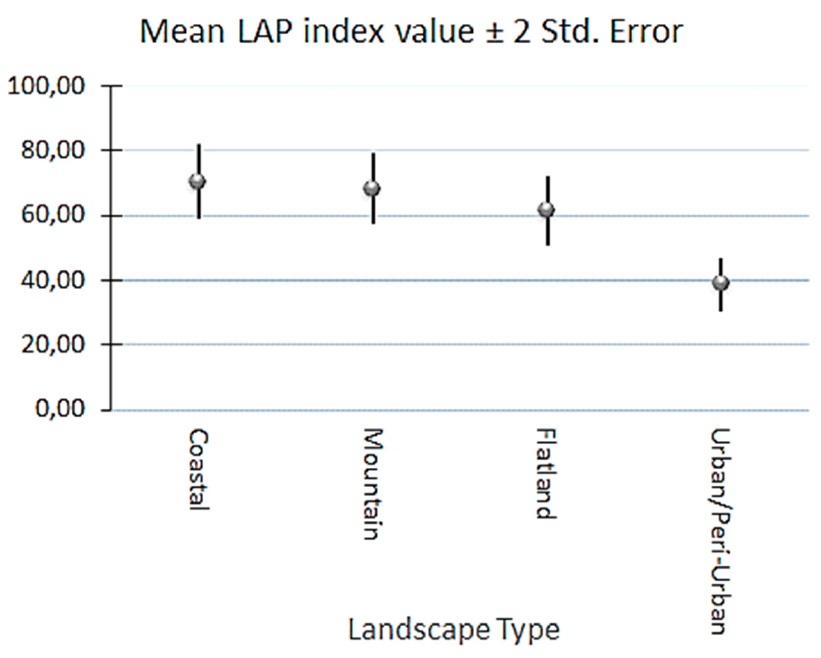
Figure 6. Mean LAP index scores per landscape type category.